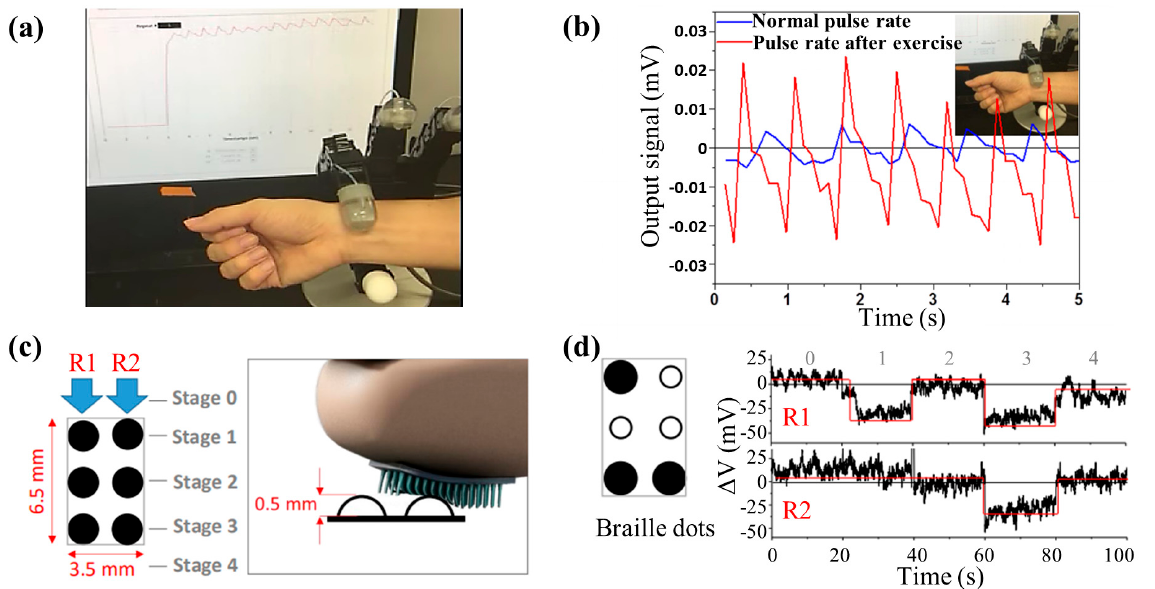
Figure 18. ( a ) Experimental scenario when the sensor is used to read pulse signal. Reprinted with permission from Ref. [63]. Copyright 2017, Springer Nature; ( b ) The pulse signals of a volunteer before and after exercise. Reprinted with permission from Ref. [63]. Copyright 2017, Springer Nature; ( c ) 2 × 3 Braille dots (corresponding to 26 English letters) and the test diagram. Reprinted with permission from Ref. [116]. Copyright 2016, IEEE; ( d ) Test results when the sensor is used to distinguish Braille dots. Reprinted with permission from Ref. [116]. Copyright 2016, IEEE.